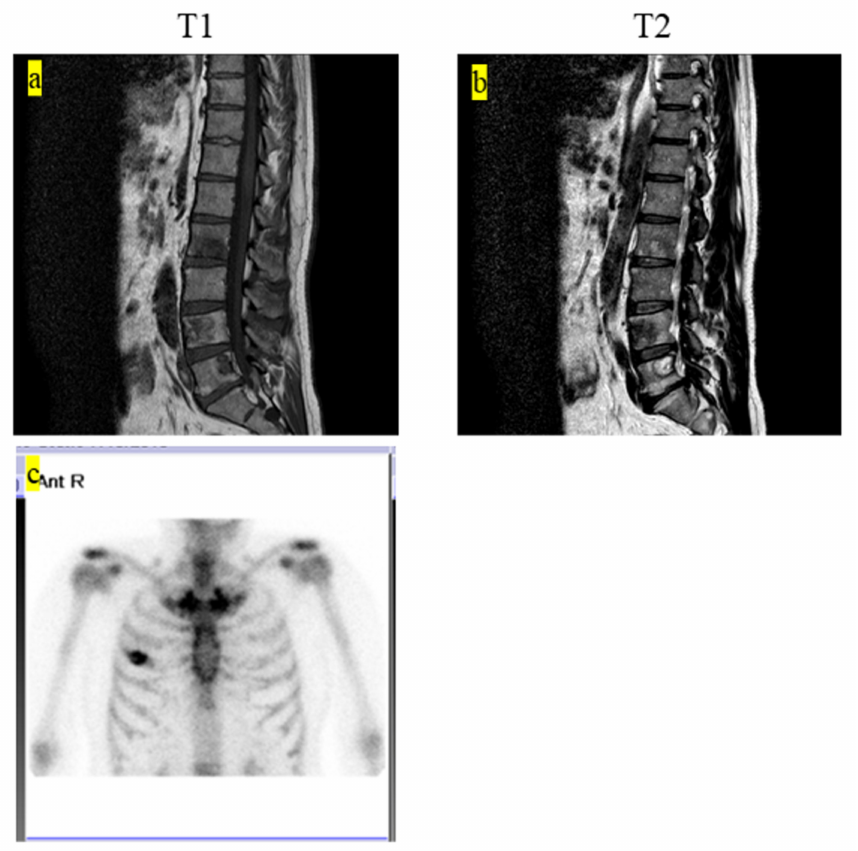
Figure 1. ( a ) T 1 -weighted MRI showing multiple low-intensity lesions. ( b ) T2-weighted MRI showing multiple low- and high-mosaic intensity lesions. ( c ) Bone scintigraphy shows the accumulation of the radiotracer on the right fourth rib. MRI, magnetic resonance